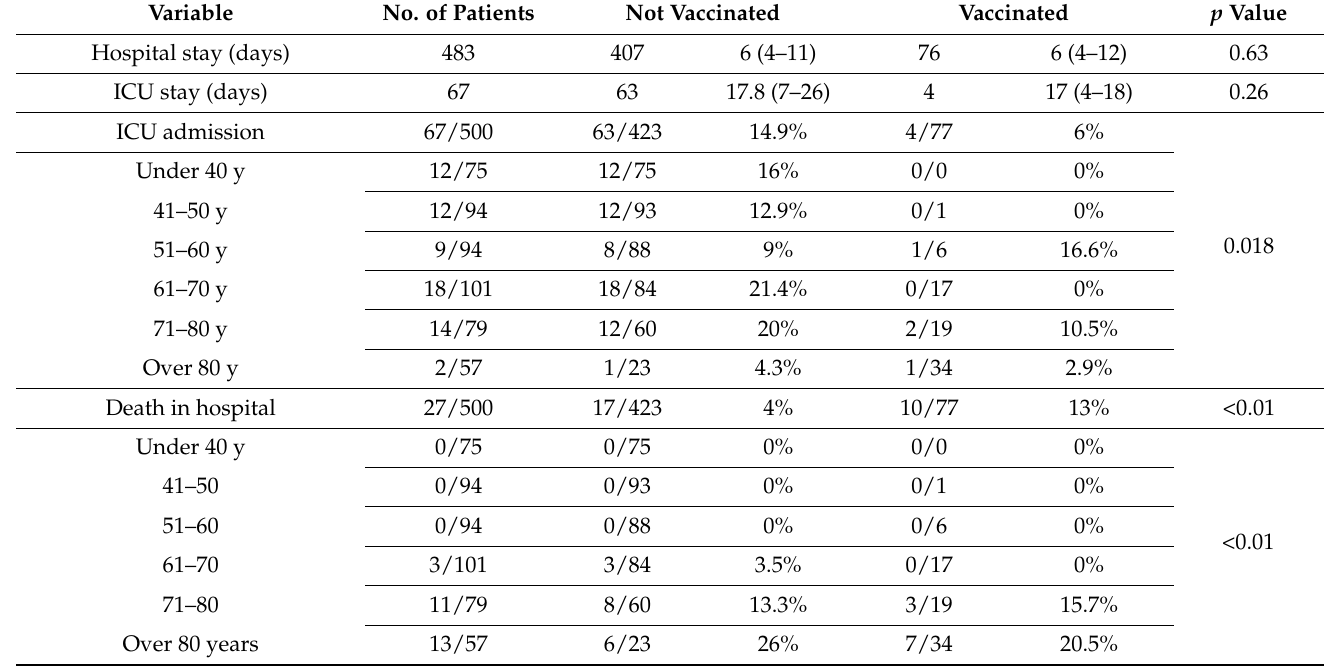
Table 5. Hospital stay and evolution in the not vaccinated and vaccinated cohorts